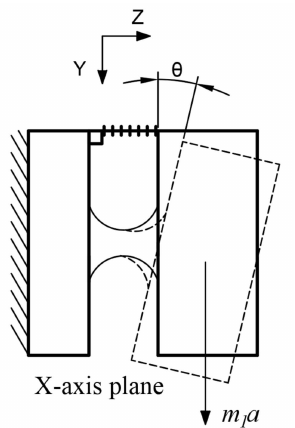
Figure 3. Force analysis diagram of x-direction